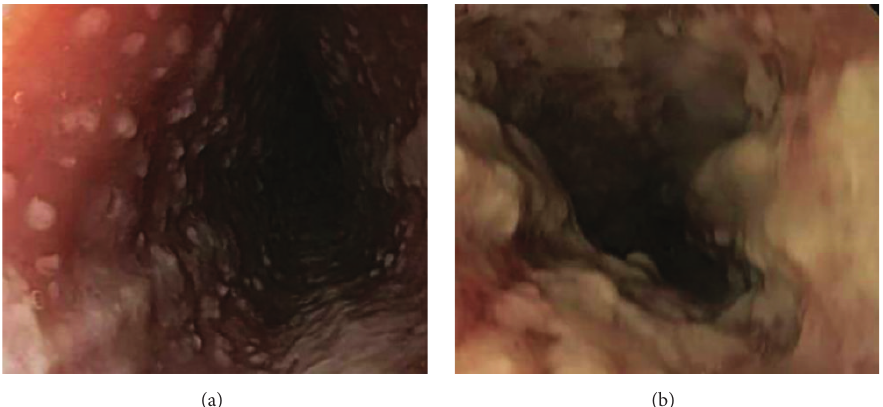
Figure 1: Endoscopy shows multitudes of small ulcers with normal intervening mucosa (a) and areas of confluent plaque-like lesions (b) in the distal esophagus.